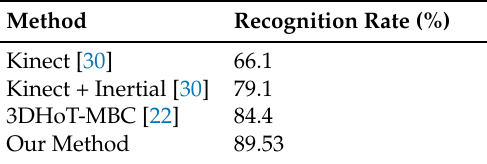
Table 9. The recognition accuracy comparison with other methods on